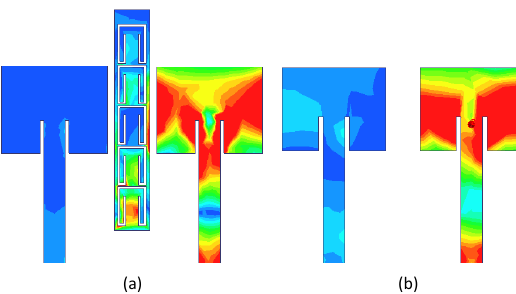
Figure 4. ( a ) Surface current distribution of MIMO antenna with metamaterial, ( b ) Surface current distribution without